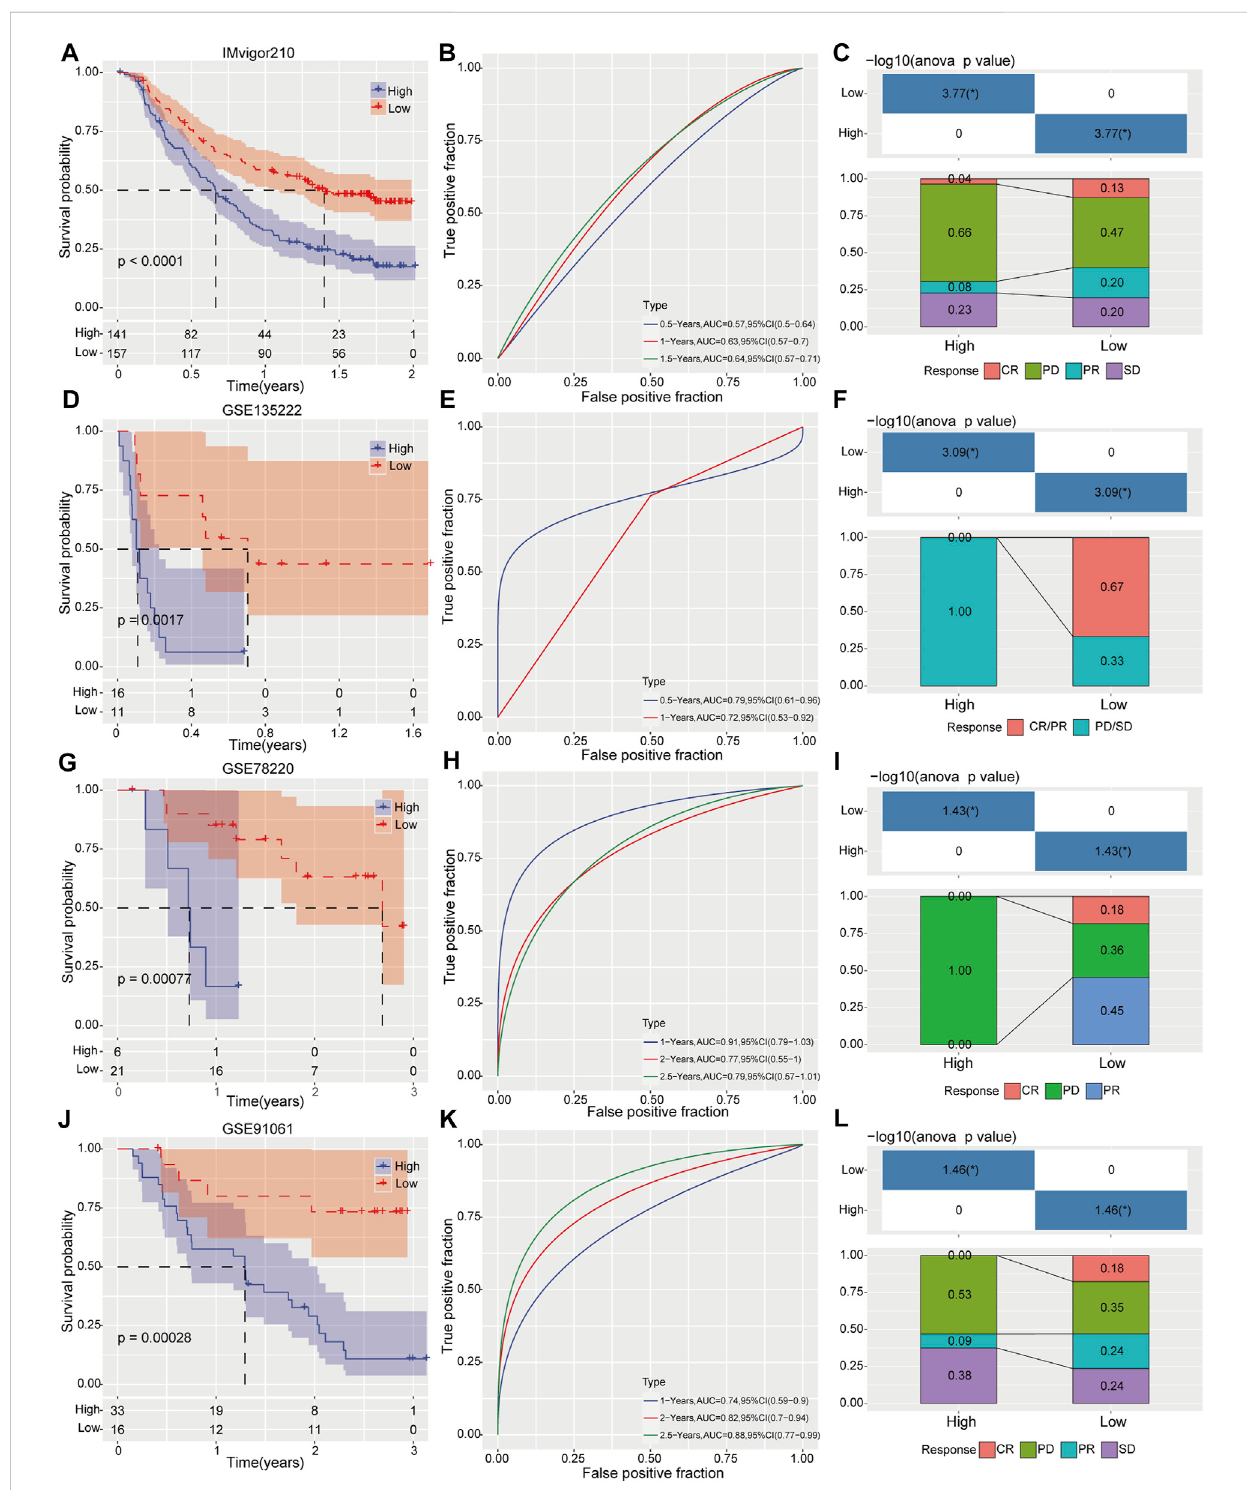
FIGURE 7 Evaluation prognostic risk model on survival prediction and immunotherapy response. Clinical outcomes and immunotherapy response between high-andlowriskgroupsweredeterminedbyKaplan-Meieranalysis,ROCcurveandimmunotherapyresponsedistributionanalysisinIMvigor210cohort (A – C) , GSE135222 cohort (D – F) , GSE78220 cohort (G – I) and GSE91061 cohort (J – L) ,